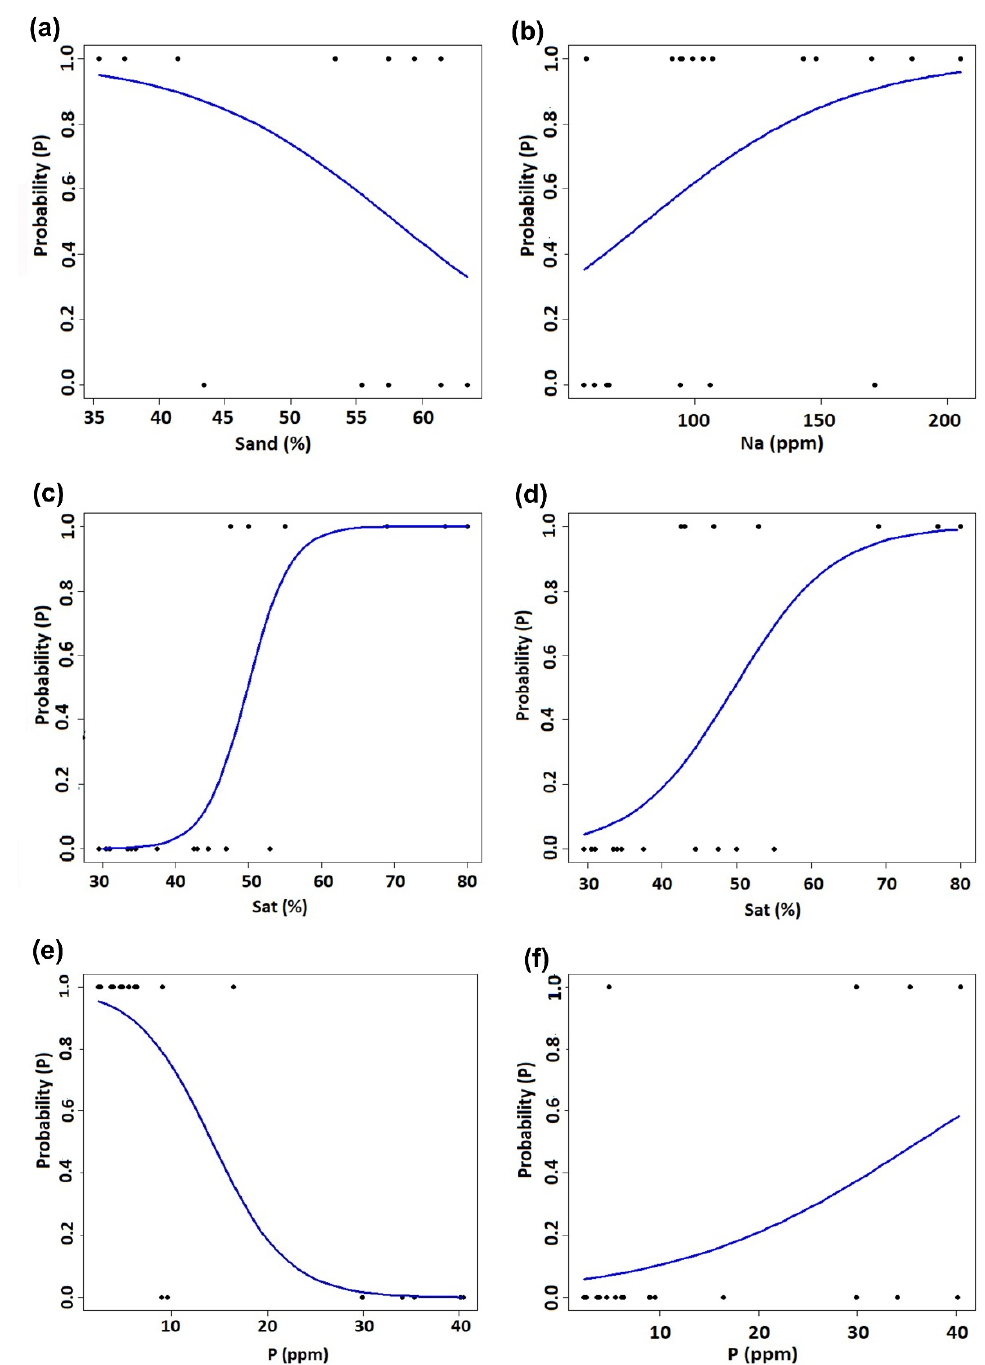
Figure 3. Probability (P) of the presence of species in relation to soil components according to the BLM ( p < 0.05): ( a ) Viola grahamii , ( b ) Phaseolus parvulus , ( c ) Acmispon wrightii , ( d ) Agastache pallida, ( e ) Ceanothus depressus, ( f ) Penstemon miniatus . P (phosphorus, ppm), Na (sodium, ppm), Sat (Water saturation, %).